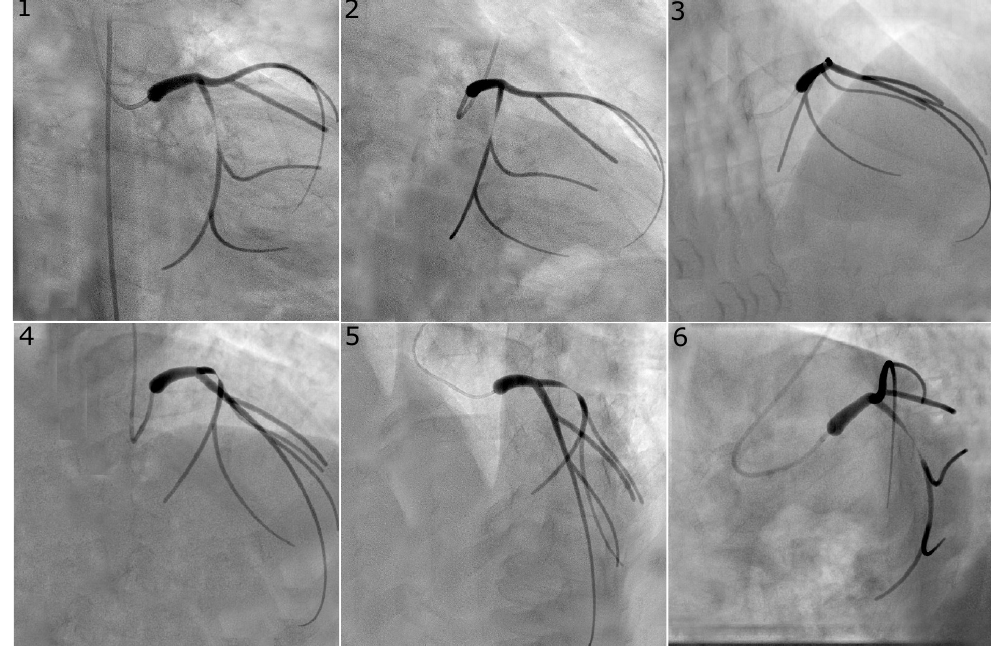
Figure 2. Virtual angiogram for all views of the left coronary system with a concentric stenosis of 80% diameter reduction in the LCX. Views 1 , 2 , and 6 were used to reconstruct this vessel as they are usually selected in the catheterisation laboratory since they avoid vessel overlap and excessive foreshortening for the vessel of